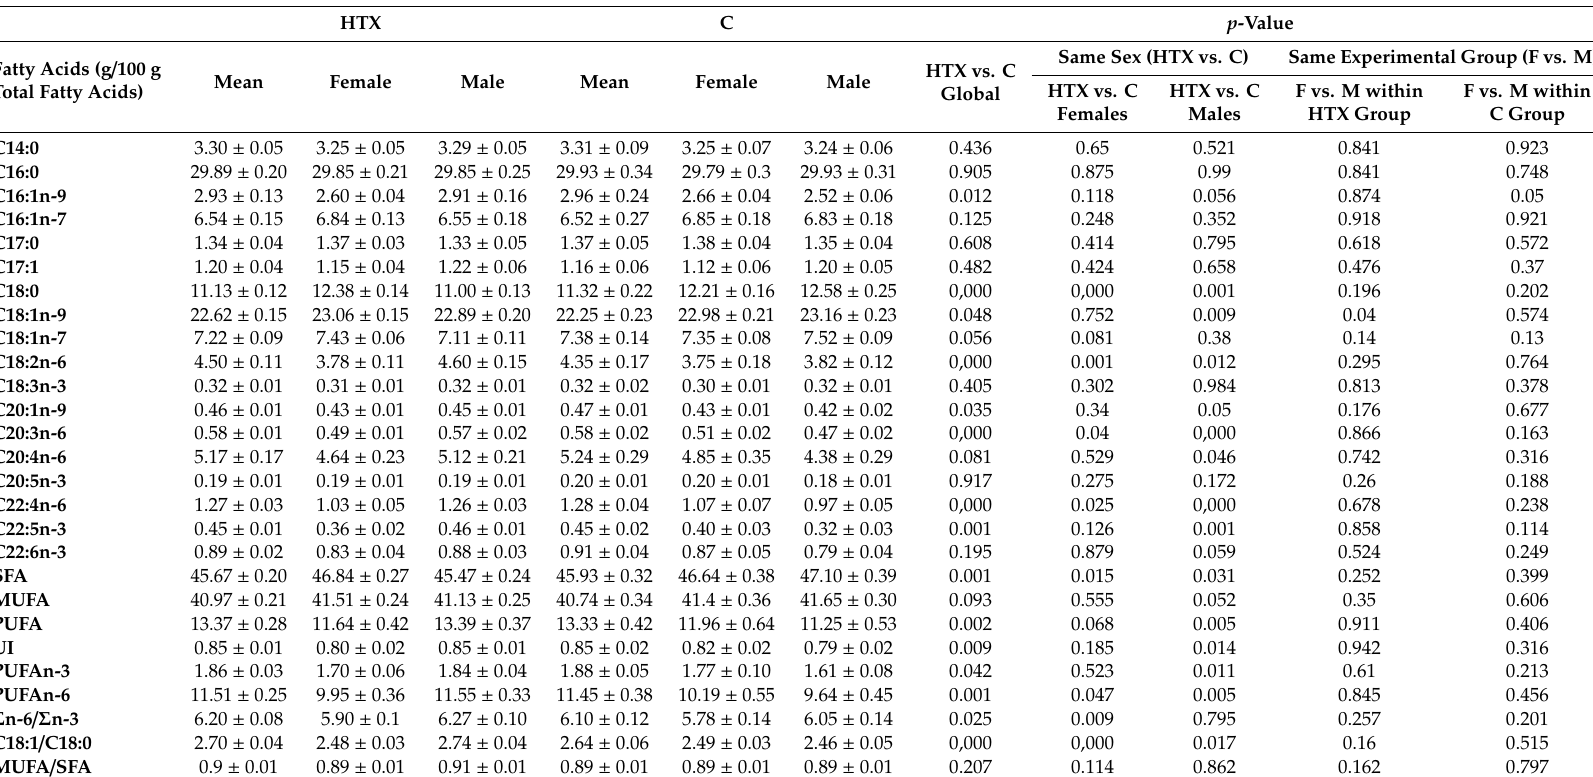
Table 4. E ff ects and di ff erences between sexes, of maternal hydroxytyrosol supplementation on the fatty acid profile of the fetal longissimus dorsi muscle. Mean values ( ± SEM) of neutral lipids in female (F) and male (M) fetuses of the treated (HTX) and the control group (C). HTX C p -Value Fatty Acids (g / 100 g Mean Female Male Mean Female Male Total Fatty Acids)